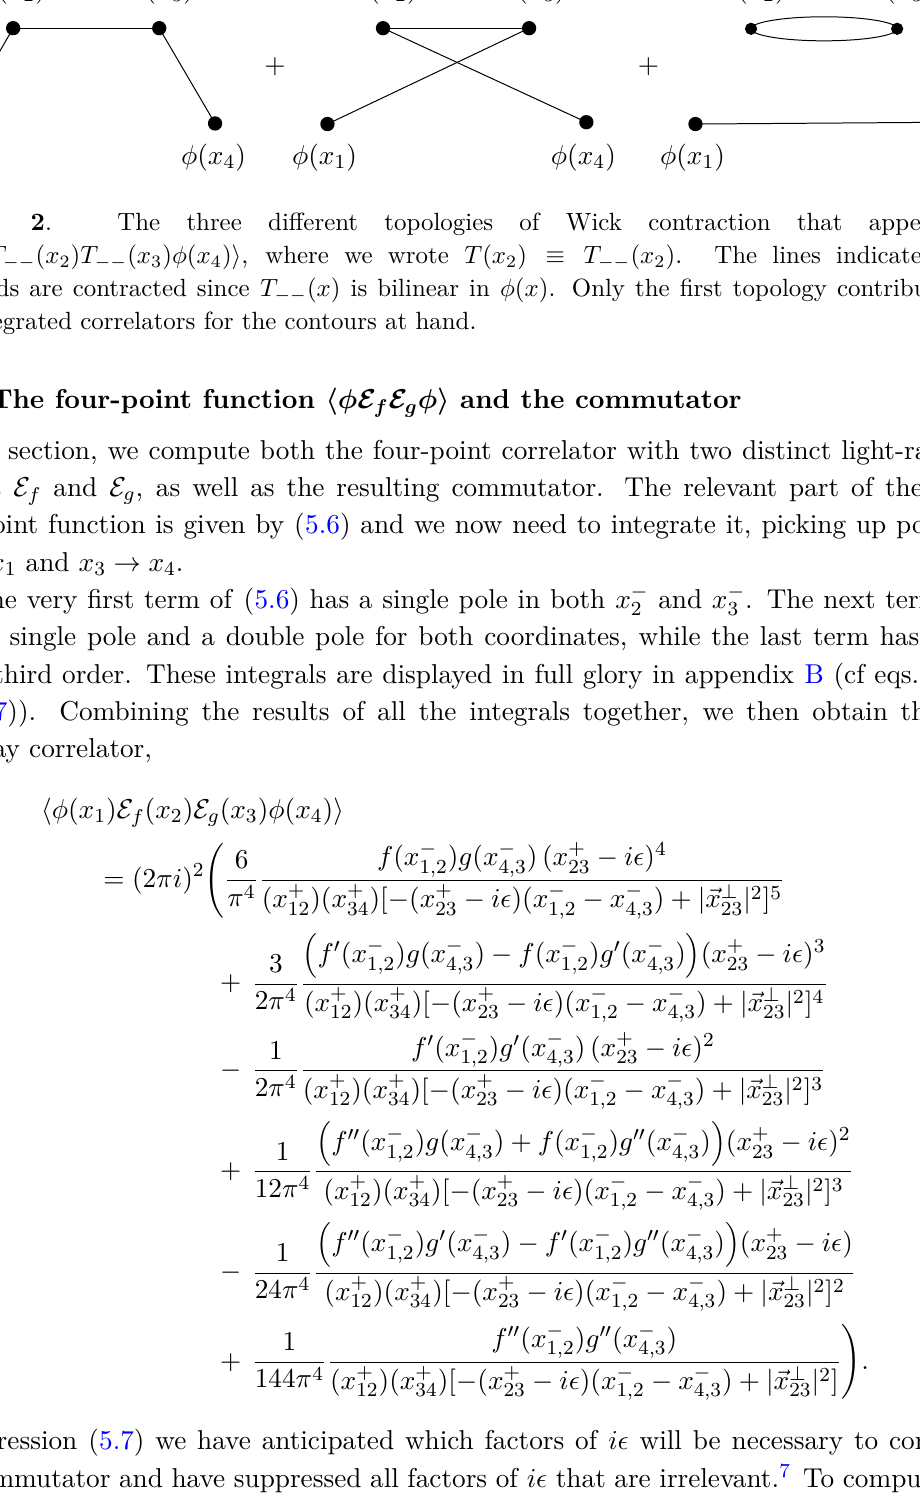
Figure 2 . The three different topologies of Wick contraction that appear in